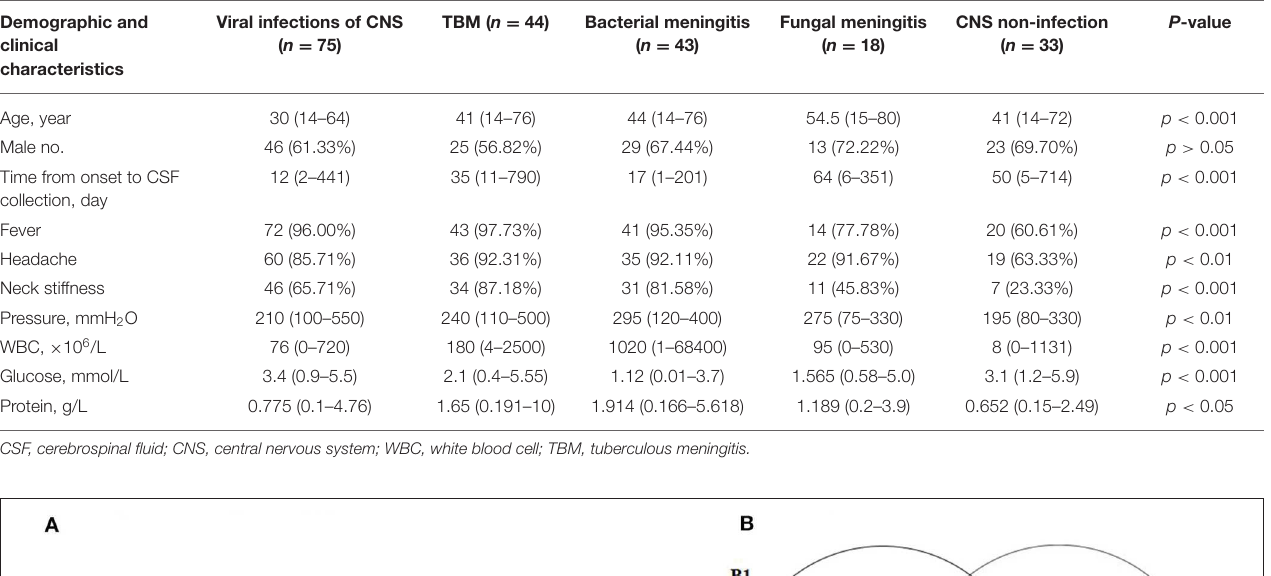
( Table S3 ) and the AUC was largest (0.846, 95% CI = 0.711– 0.981). In brief, among the 43 patients with presumed bacterial meningitis (15 definite and 28 probable), mNGS identified a bacterial pathogen in 24 (55.8%, 24/43); conversely, the CSF combined Gram stain/culture-positive rate was only 32.56% (14/43). Combination of the two methods increased the positive rate to 62.79% (27/43) ( Figure 2B 2). In the 24 patients with positive mNGS results (SSRNs ≥ 5 or 10), the top three pathogens were S. pneumoniae (41.7%, 10/24), K. pneumoniae (12.5%, 3/24), and Listeria monocytogenes (8.3%, 2/24). Of note, among the patients with non-bacterial meningitis, 4.1% (7/170)